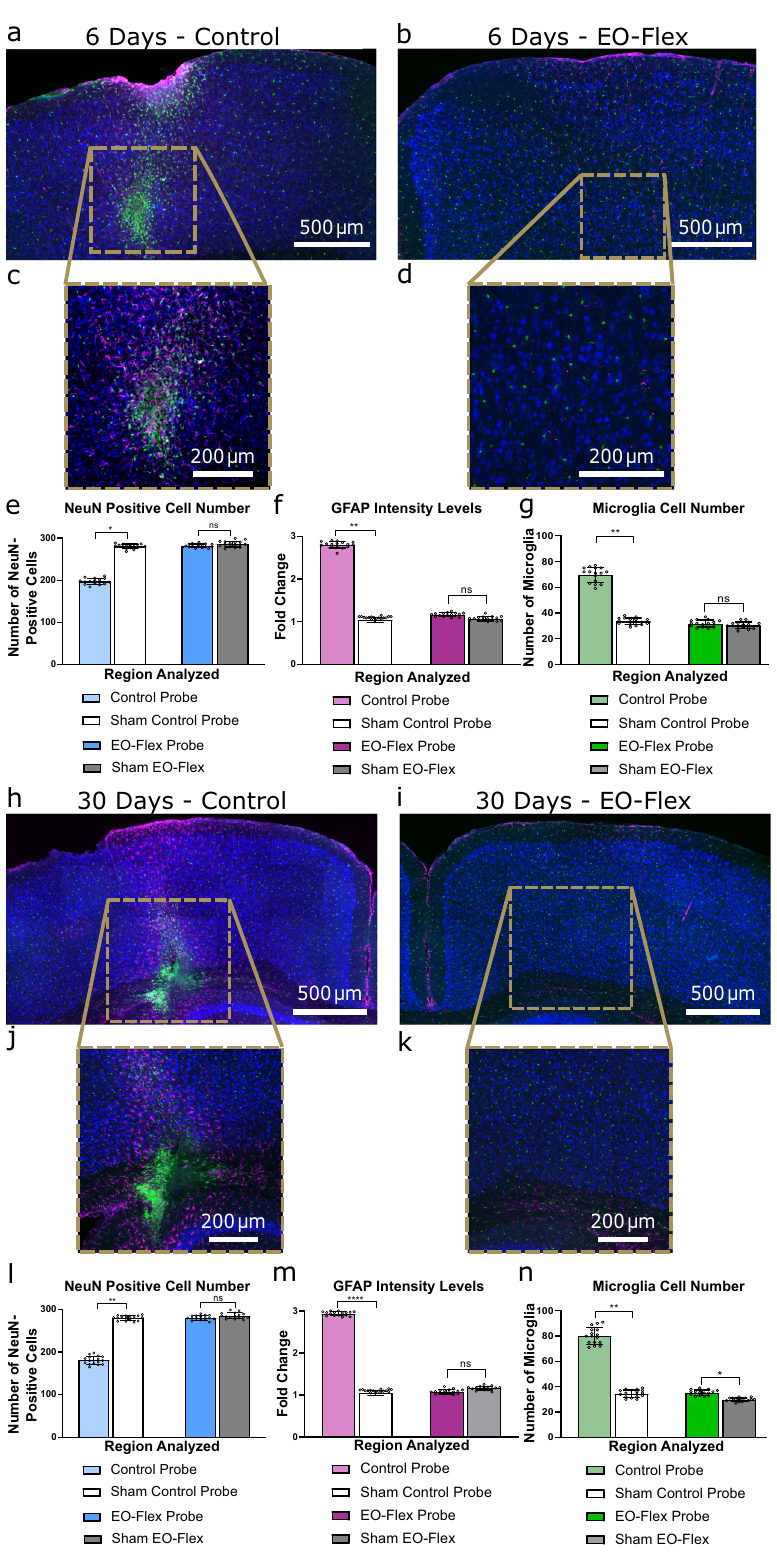
Stereotactic viral vector injection . Surgical procedures closely followed pre- viously established protocols 33,34 . Brie fl y, thin-wall glass pipettes were pulled on a Sutter Flaming/Brown micropipette puller (model P-97). Pipette tips were cut at an acute angle under 10× magni fi cation using sterile techniques. Tip diameters were typically 15 – 20 μ m. Pipettes that did not result in sharp bevels nor had larger tip diameters were discarded. Millimeter tick marks were made on each pulled needle to measure the virus volume injected into the